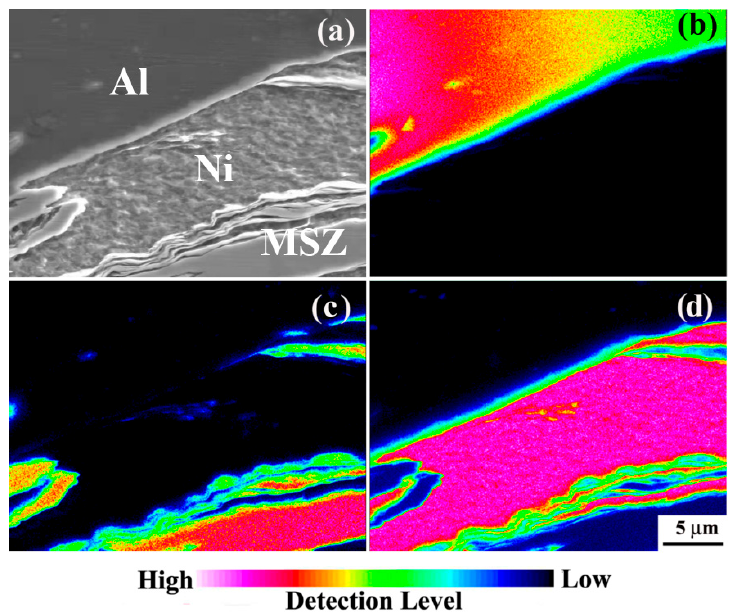
Figure 5. SEM images ( a ), and a map distribution of ( b – d ) Al, Fe and Ni elements for weld process III by EPMA.